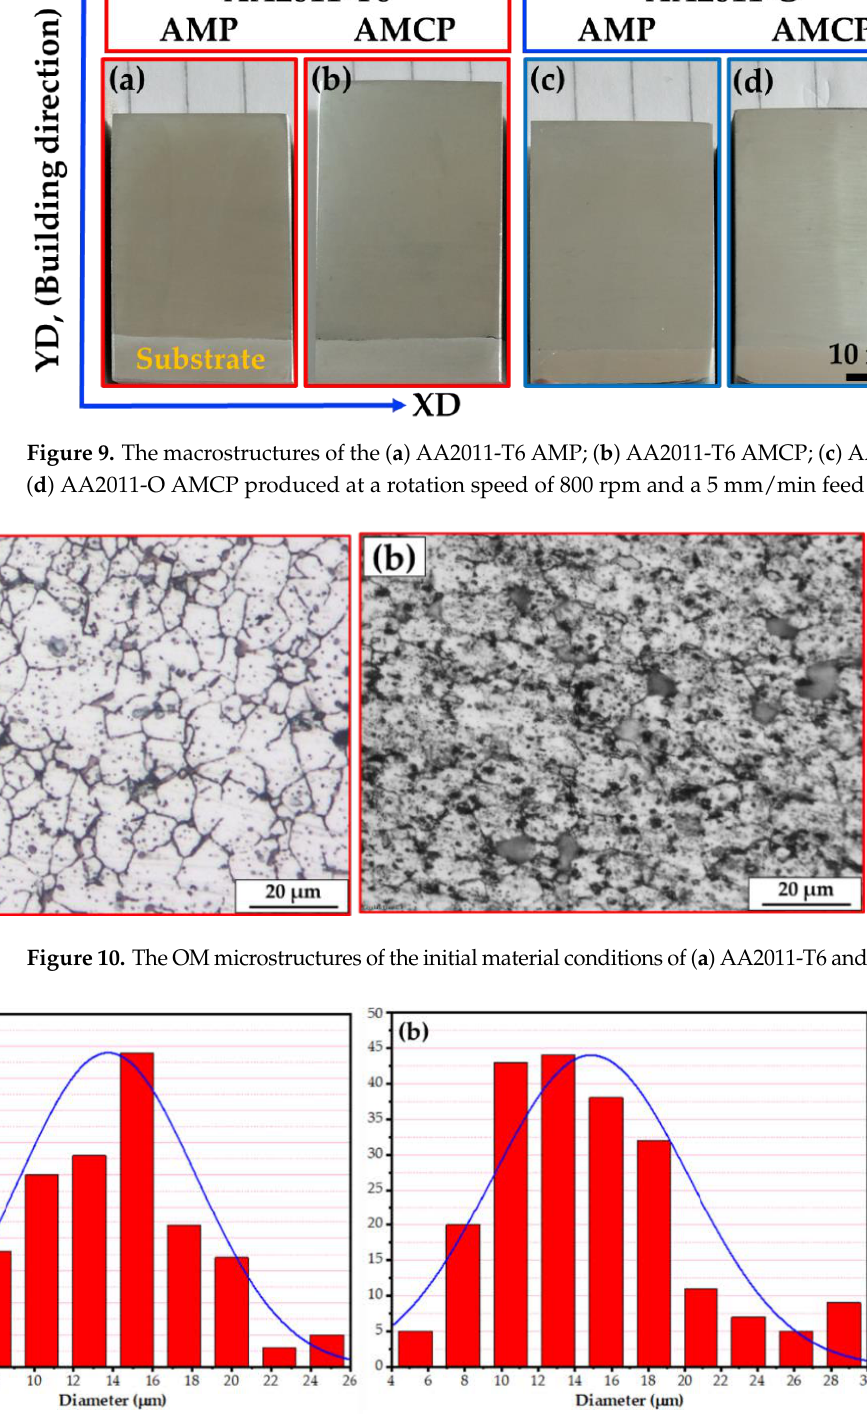
Figure 11. The grain size analysis of the initial material conditions of ( a ) AA2011-T6 and ( b ) AA2011-O. The FSD, as a thermomechanical process, is identical to friction stir processing (FSP) [45,46,50] in terms of heat mechanisms (i.e., generation, dissipation, and transfer)